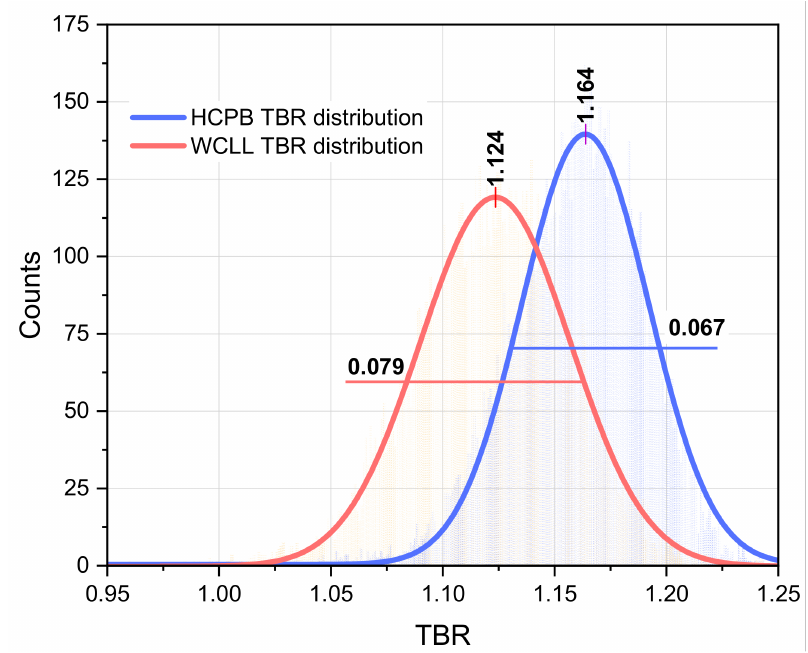
Figure 9. TBR statistical distributions for the HCPB and WCLL